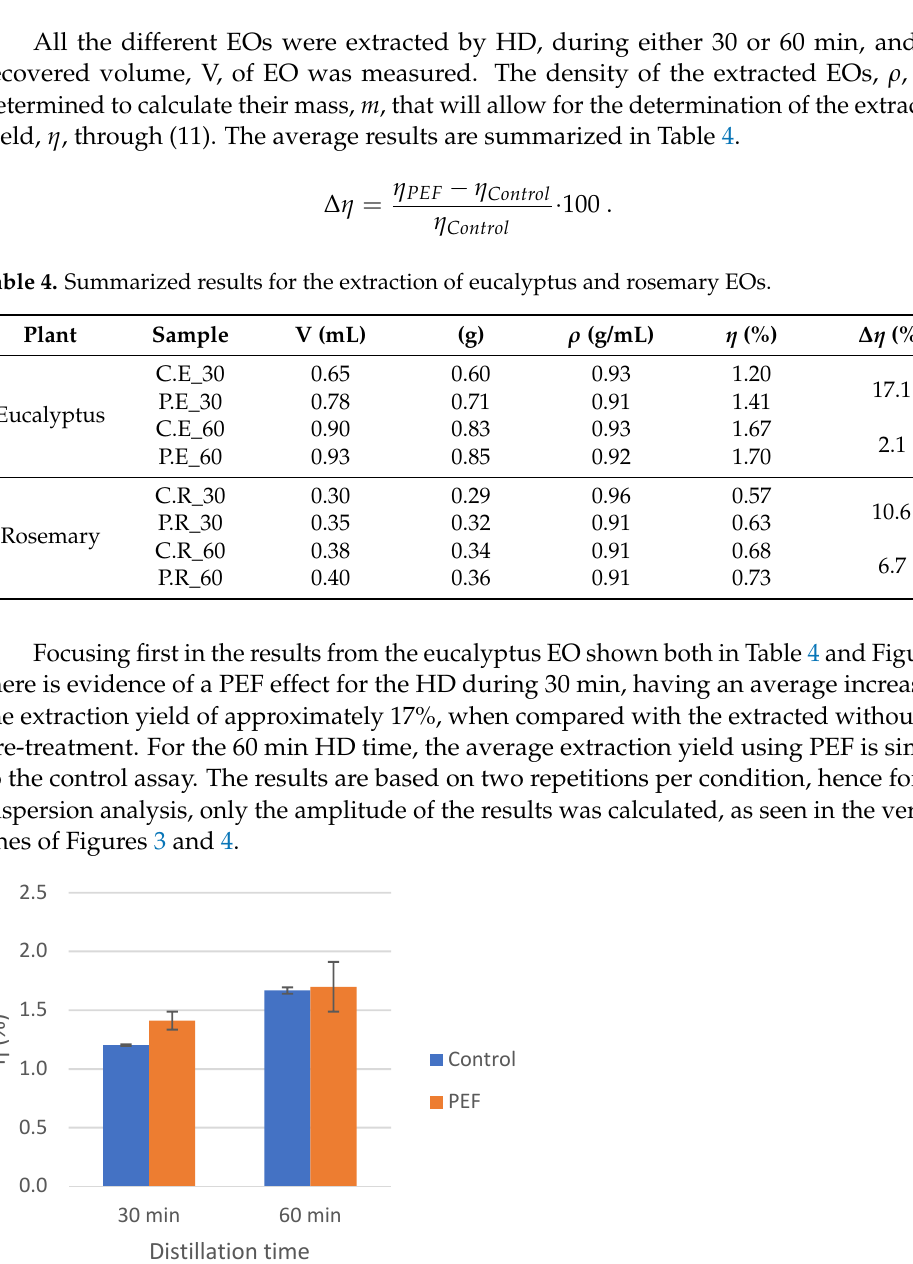
Table 3. Description of the code name of the different samples. Control C Condition PEF P Eucalyptus E Plant Material Rosemary R 60 min 60 Distillation Time 30 min 30 Replica 1, 2